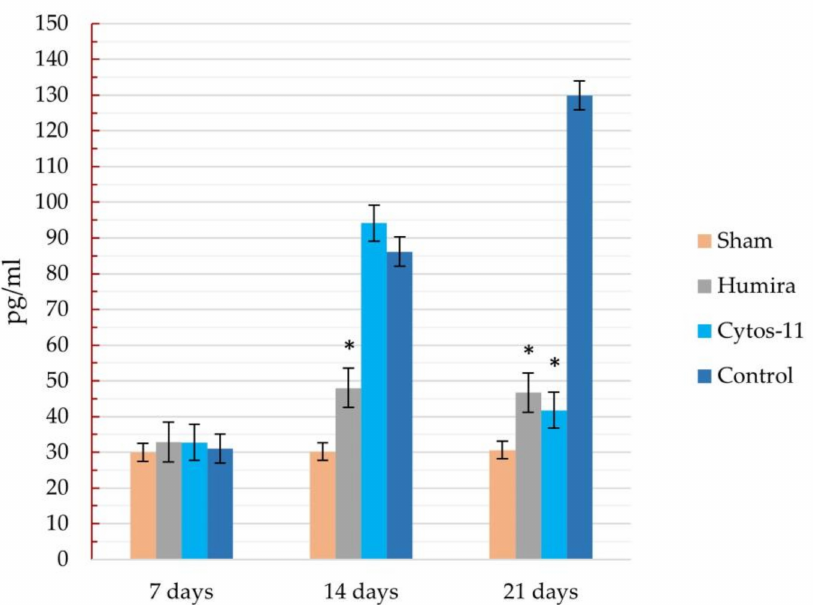
Figure 4. Dynamics of changes in the concentration of TNF- α in peripheral blood in different groups of the experiment. * Significant differences compared to the control group. I—error of the